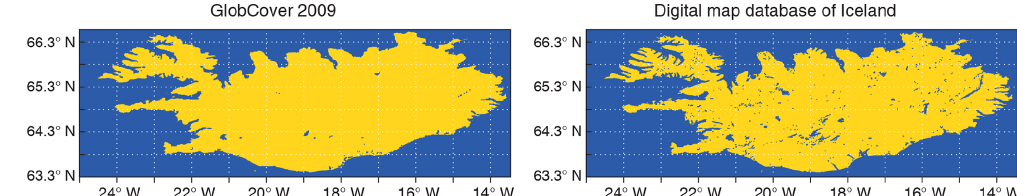
Figure 5. Water distribution for Iceland using GlobCover 2009 and the Digital map database of Iceland; yellow colour indicates land, and dark blue indicates